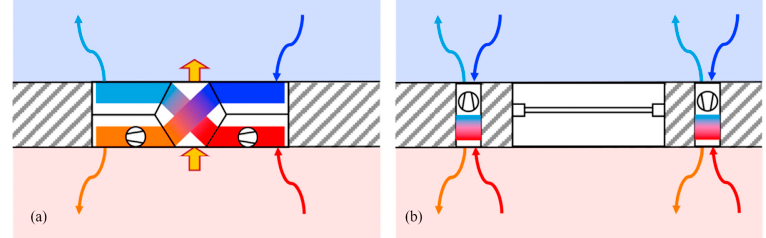
Figure 13 . Facade system with ( a ) counter flow heat recovery and ( b ) regenerative heat recovery [46] .